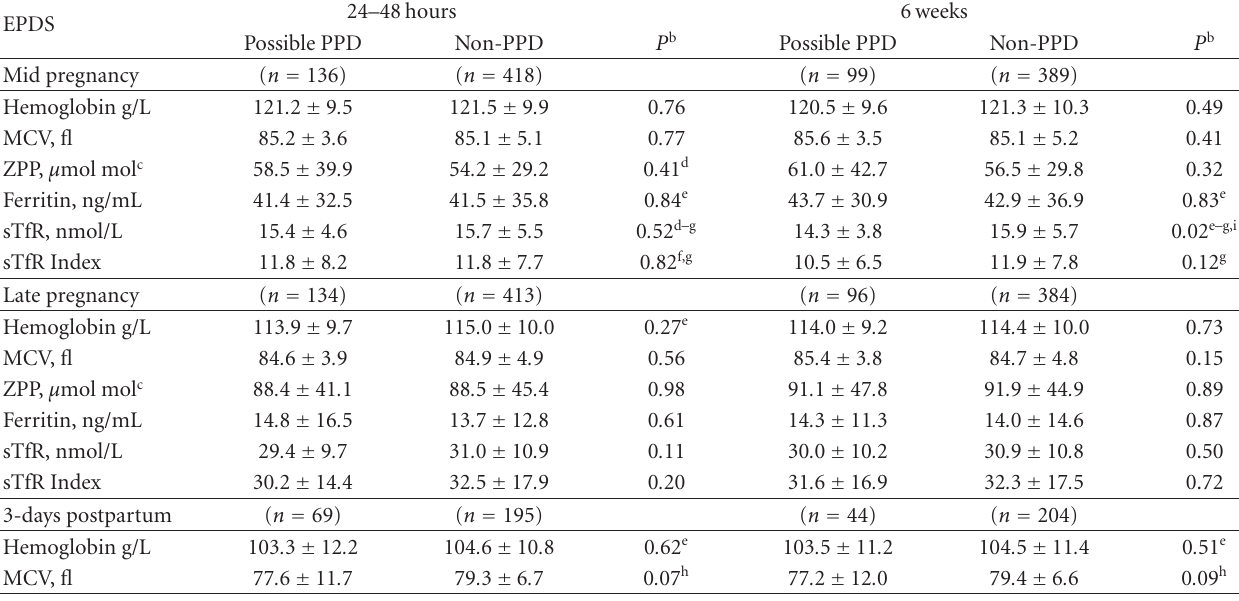
Table 5: Iron status in mothers with possible PPD and non-PPD in the confirmatory sample a .